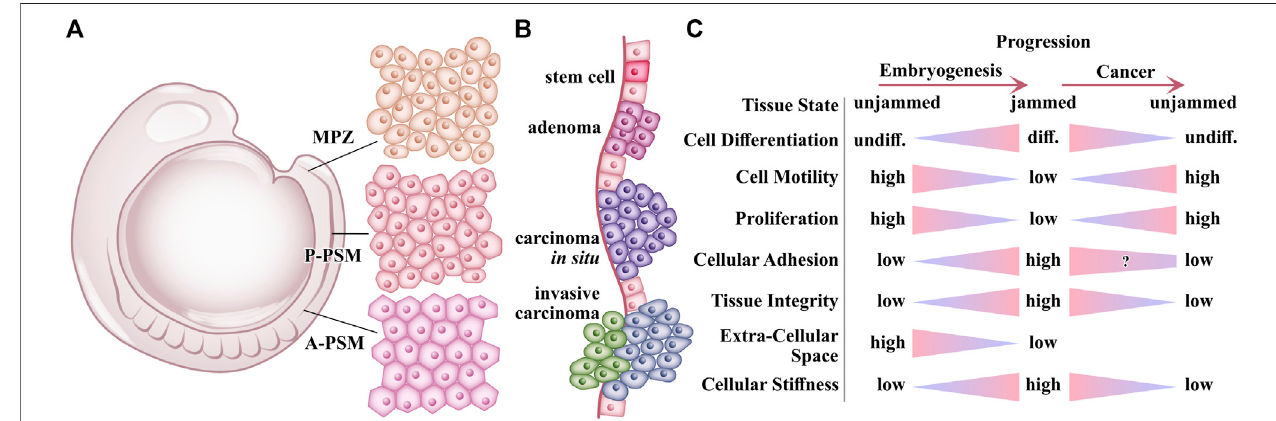
FIGURE 6 | Occurrence of Jamming and unjamming in embryogenesis and cancer. (A) Illustration of the lateral view of zebra fi sh embryo in the 10-somite stage. During periodic rapid elongations at the tail of the embryo, cells from the mesodermal progenitor zone (MPZ) transform to cells of the posterior (P-PSM) presomitic mesoderm and consecutively to anterior presomitic mesoderm (A-PSM). During this transformation, the initial cells of the MPZ slowly decrease the cell motility, fi lling the voidsoftheextracellularspace,andrestructuringtheirN-cadherin-mediatedadhesionwithneighboringcellsresultinginincreasedtissuestiffnessandintegrity[10]. (B) Cancer progression during early stages. Growing factors like TGF- β limit the growth of normal epithelium and early-stage tumors resulting in adenomas. After losing growth-inhibitoryresponsiveness, tumors grow more rapidly, transforming intocarcinomas insitu . Additionaloncogenic mutations areacquired during rapidgrowth. By chance, tumor cells with speci fi c oncogenic mutations can undergo epithelial-mesenchymal transdifferentiation in response to TGF- β and are becoming more invasive carcinomas [90]. (C) Overview of changes on tissue and cellular level during embryogenesis and cancer progression. Various processes and properties which change during embryogenesis are reversed during cancer progression, motivating the hypothesis of cancer being inverse morphogenesis [87, 88,